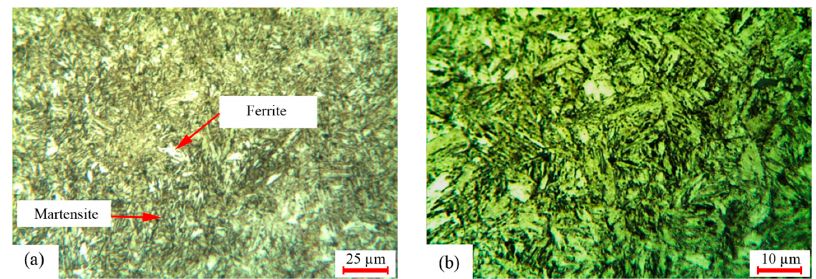
Figure 14. ( a ) AISI 4130 microstructure of furnace hardened quenched in oil magnitude of 200 × ; ( b ) magnitude of 500 × .